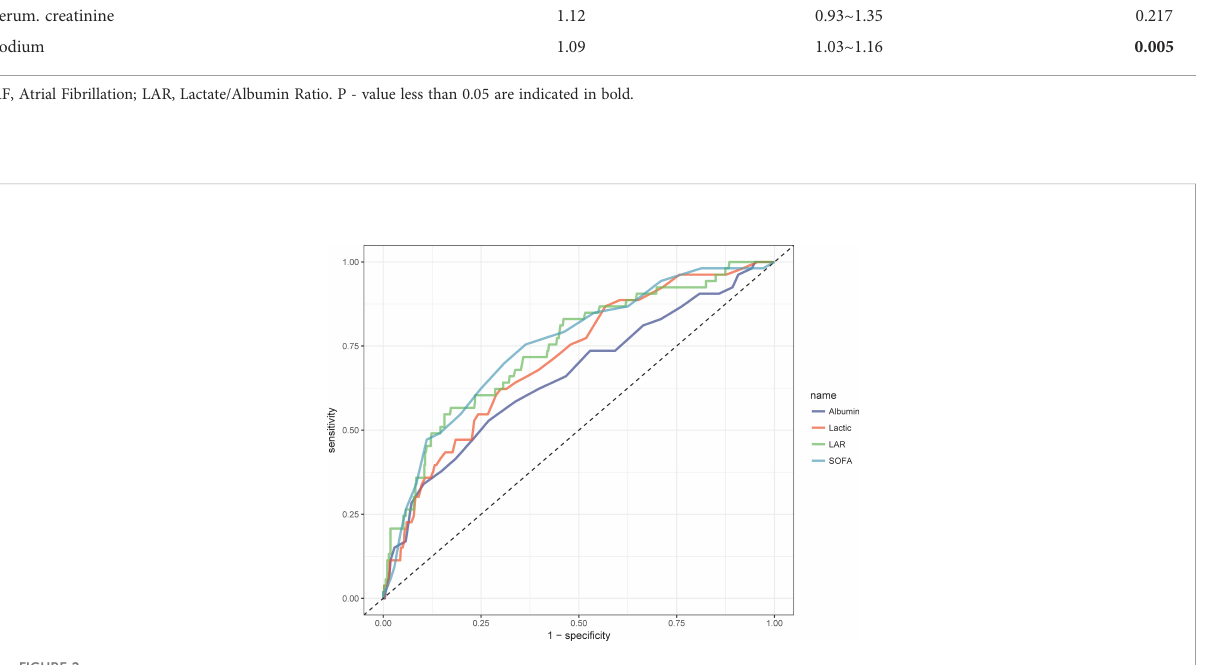
FIGURE 2 ROC curves of peripheral differential leukocyte count correlate for predicting in-hospital mortality. The green solid line indicates the ROC curve of the LAR. The red solid line indicates the ROC curve for Lactate. Deep blue indicates the ROC curve of Albumin. LAR, lactate/albumin ratio; SOFA, Sequential Organ Failure Assessment.